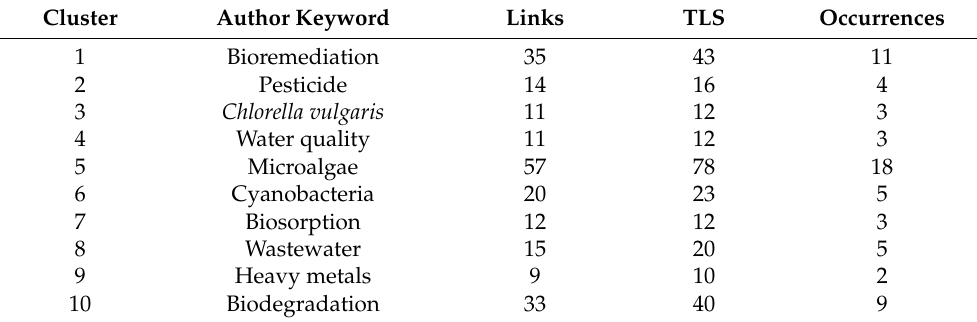
Table 5. List of author’s keywords as central of top 10 clusters in co-occurrence’s